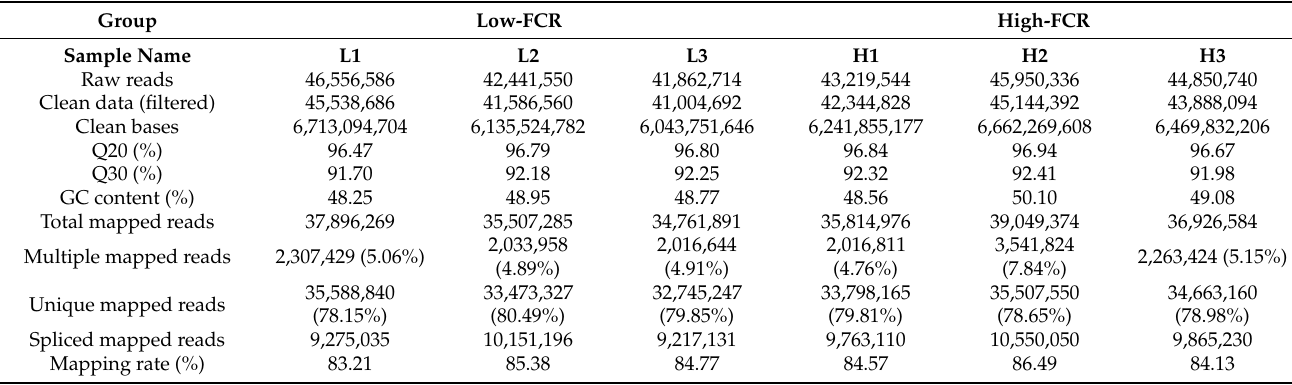
Table 2. Summary of data filtration, sequence quality and alignment for jejunal transcriptome of KR chickens with differences in feed conversion